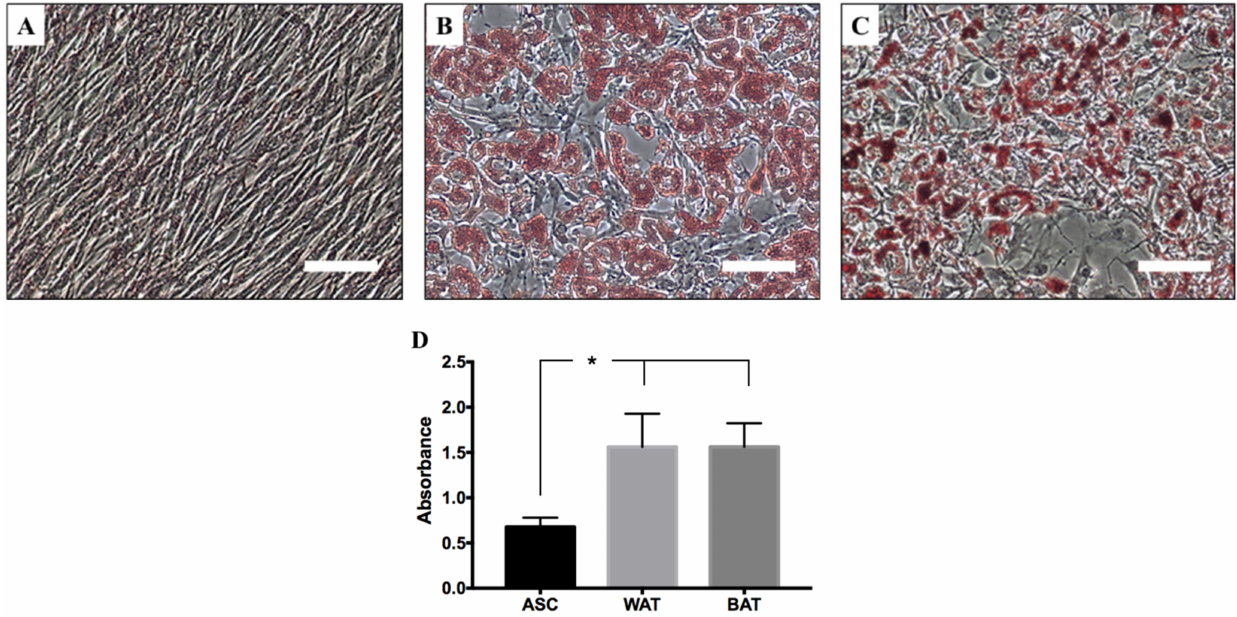
Figure 7. Adipose conversion shown by lipid staining with Oil Red O. Human ASCs at early passage (P3) expanded in Ursuppe basal medium are easily induced to differentiate into early adipocytes. Two different xeno- and serum-free induction media developed in our laboratory were used for these assays. Fold magnification 100 × . Scale bar 100 µ m. ( A ) Not induced hASC, grown on UrSuppe basal medium (negative control); ( B ) hASCs after ten days of white adipogenic induction with UrSuppe -white adipose tissue (US-WAT) medium; ( C ) hASCs after seven days of beige adipogenic induction with UrSuppe -beige/brown adipose tissue (US-BAT) medium. ( D ) Evaluation of the adipogenic differentiation based on the quantification of the Oil Red O absorbance, normalized for the number of cells present in the cell culture vessel. Data represent the mean absorbance ± SEM. To detect significant differences, a one-way analysis of variance (ANOVA) test was performed. * p -value <